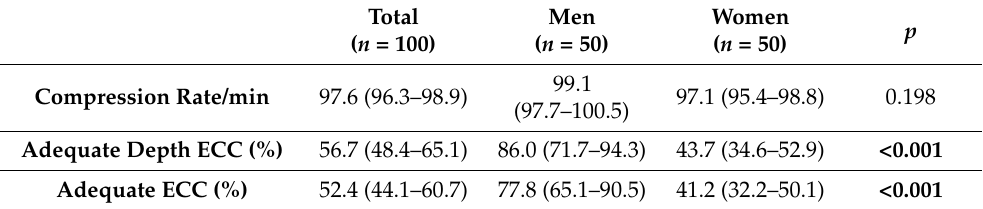
Table 2. New device quality of ECC by sex.